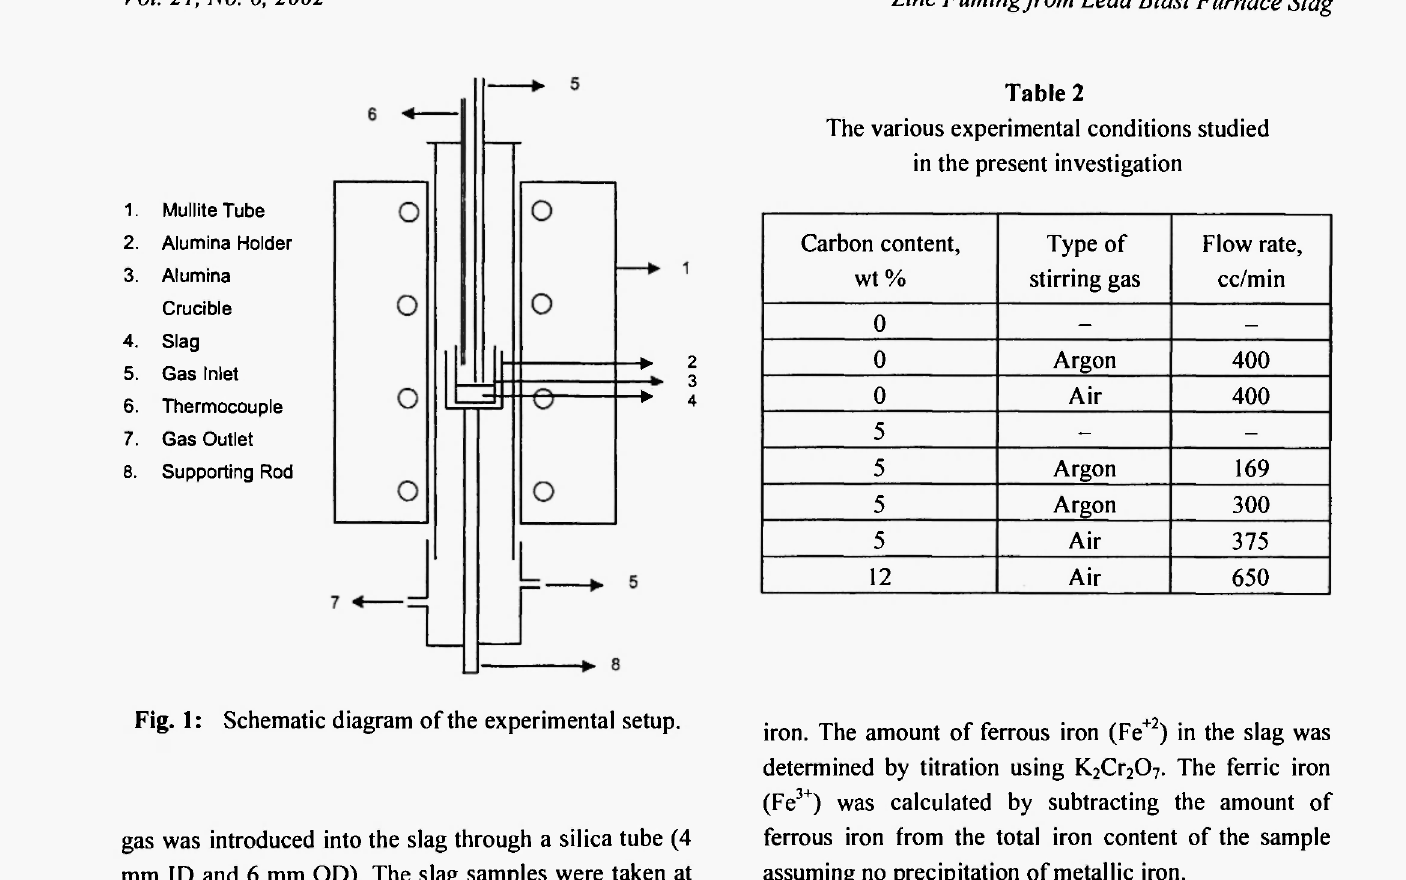
gas was introduced into the slag through a silica tube (4 mm ID and 6 mm OD). The slag samples were taken at regular intervals up to 100 minutes of the experiment